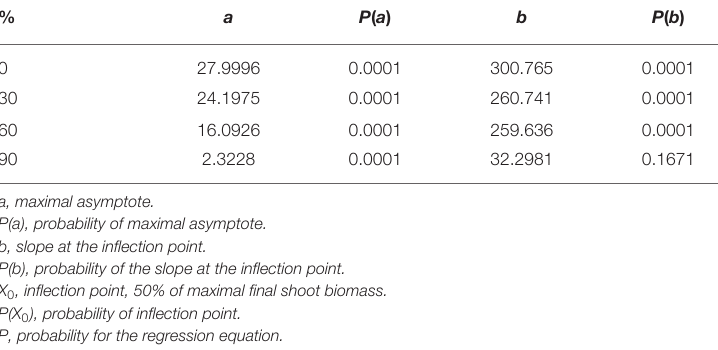
TABLE 3 | The coefficient of three parameters log-logistic equation fitted to describe the effect of shade levels on Parthenium hysterophorus final shoot biomass. Shading level Coefficient parameter